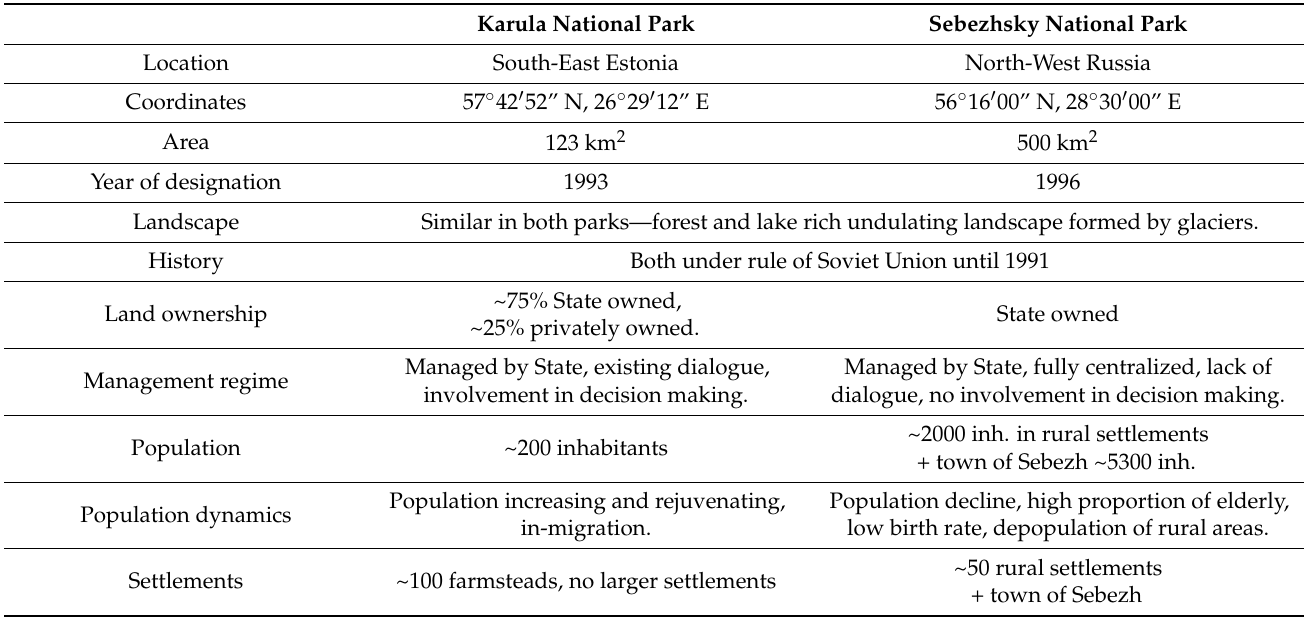
Figure 2. ( a ) Lake Ähijarv and surrounding forest in Karula National Park; ( b ) Lake Sebezh and surrounding forest in Sebezhsky National Park; ( c ) Typical managed cultural landscape in Karula National Park; ( d ) Typical overgrown cultural landscape in Sebezhsky National Park. Table 1. Comparison of the nature, management and socioeconomic contexts of the two national